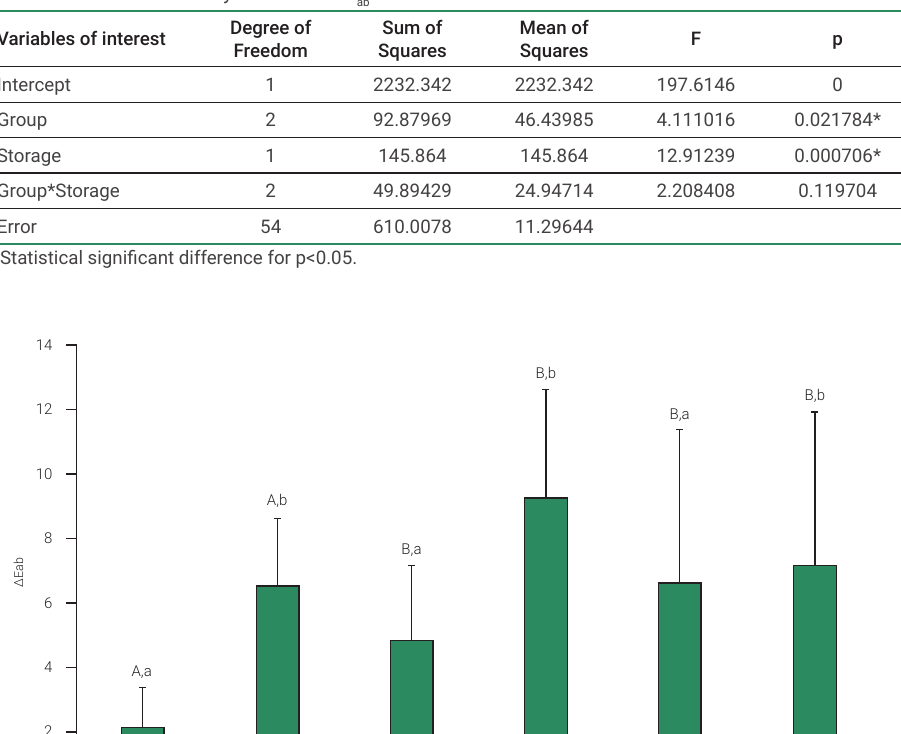
Table 1. Results from 2-way ANOVA of Δ E